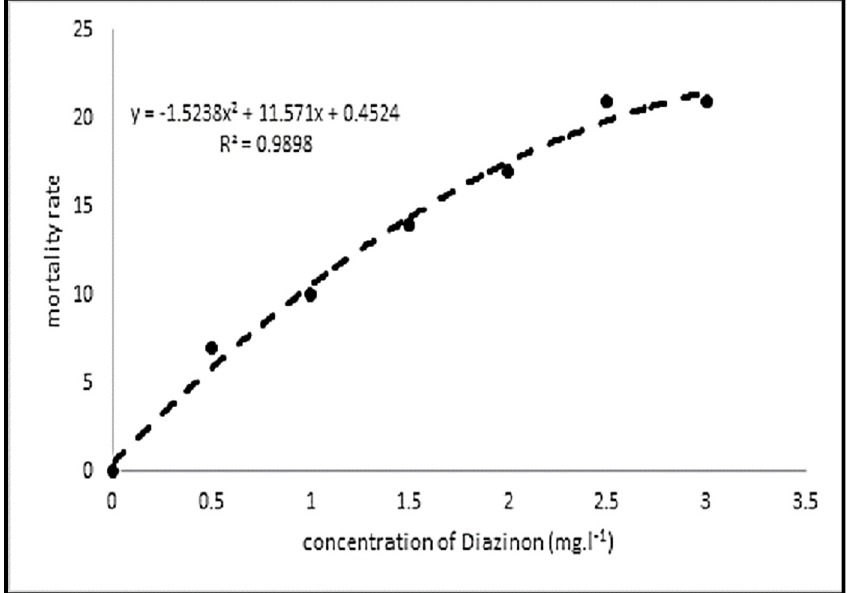
Figure 1. Correlation between mortality rates of grass carp ( Ctenopharyngodon idella ) and diazinon (DZN) concentrations after 96 h.